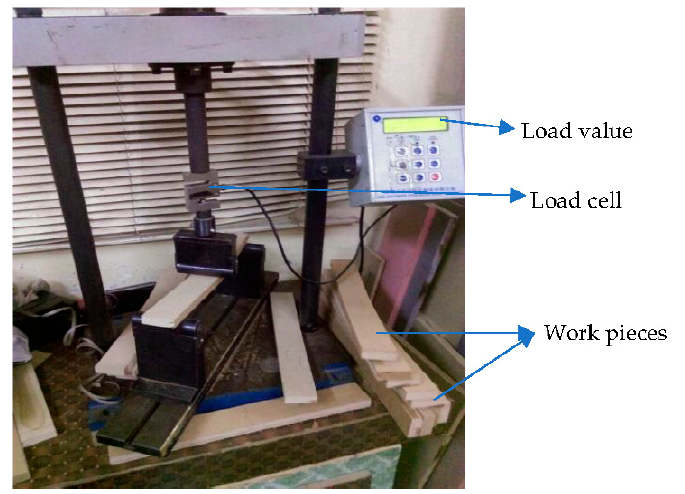
Figure 3. Wood testing machine.